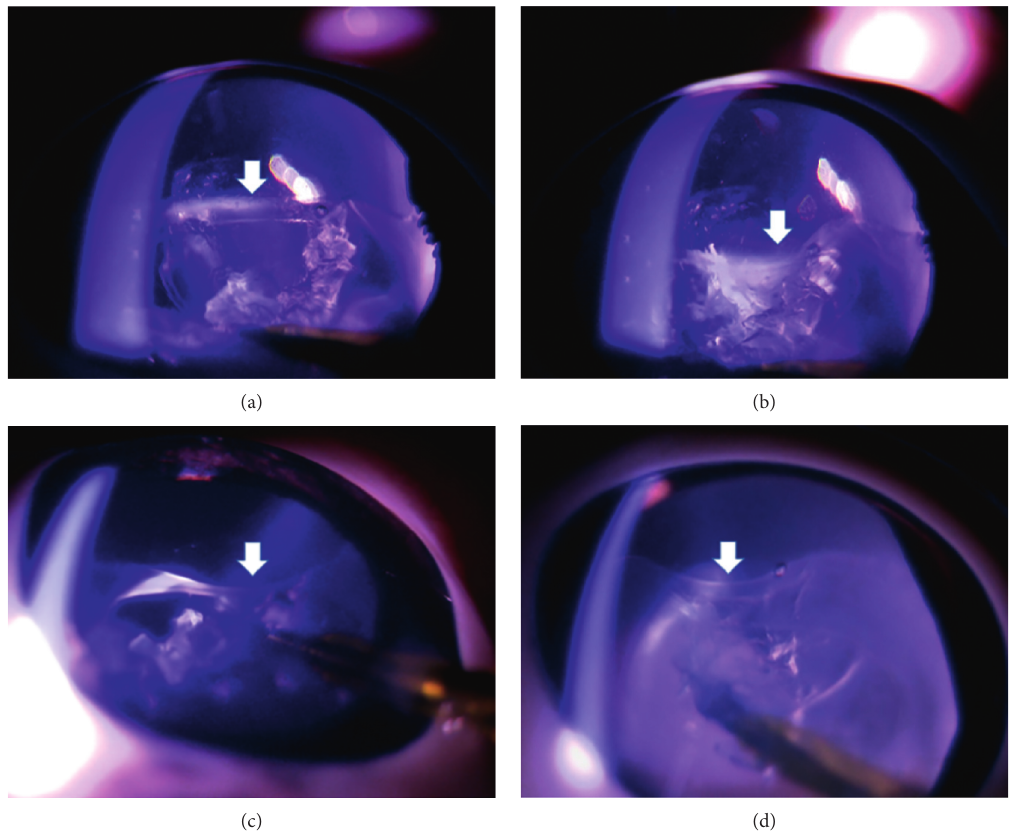
Figure 2: (a) Before phacoemulsification, the equator of the lens was in the correct position (arrow). (b)–(d) During phacoemulsification without any support in the control group, the equator of the lens was unstable (arrow) ( n �